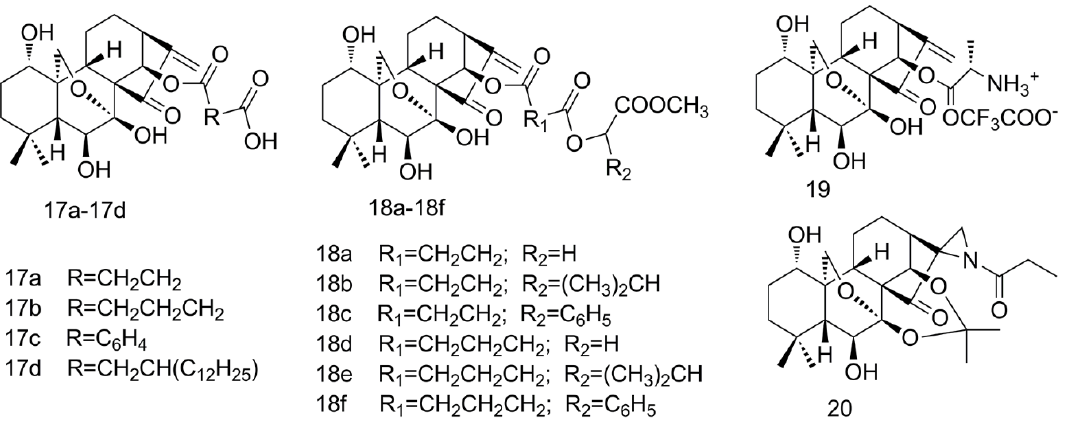
Figure 5. Amino acid modification and aziridination of ORI.